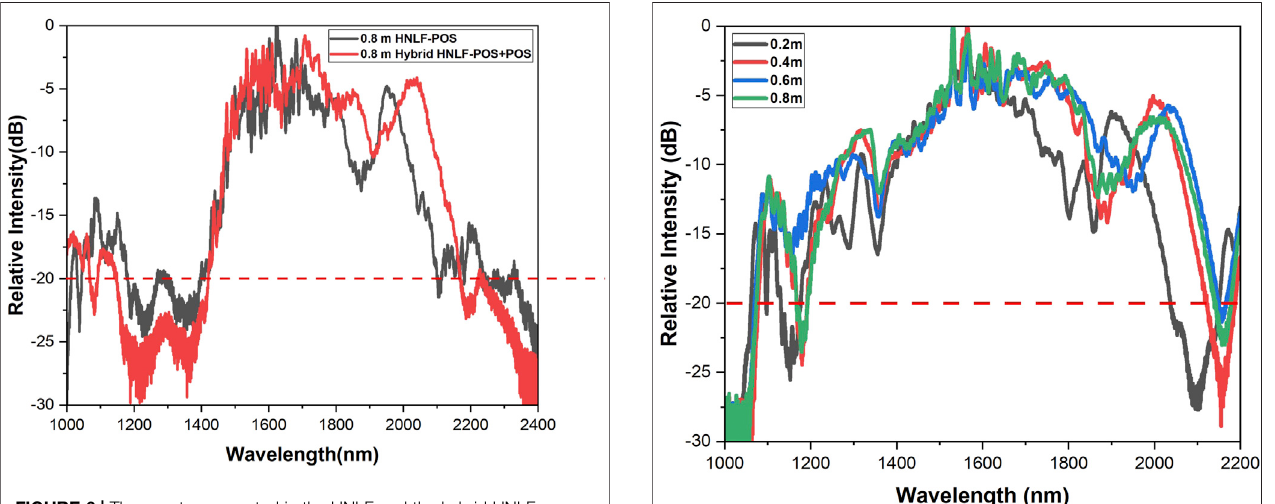
FIGURE 6 | The spectra generated in the HNLF and the hybrid HNLF. The red line is an SC generated by the hybrid HNLF with two different positive dispersion. The total GDD is close to that in the 0.8 m HNLF with D = 4.205 ps/nm/km.